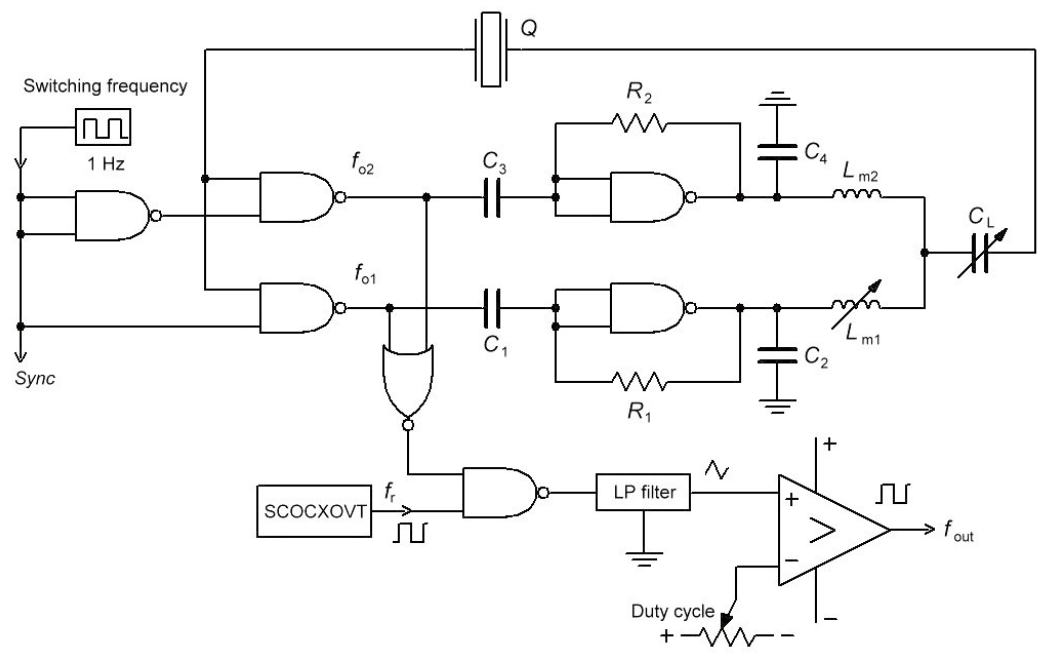
Figure 1. Dual switching mode